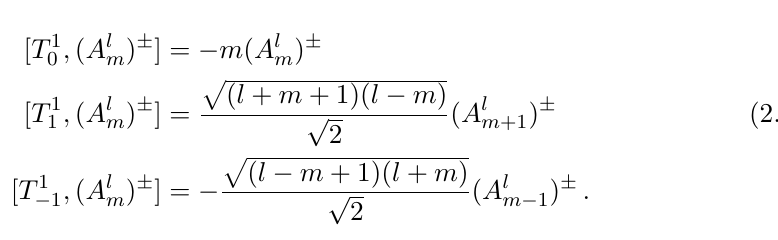
Figure 1 . Generation of chiral generators starting from A 2 to obtain A ‘ and then acting with T A ∓ = A 1 ∓ 1 ∓ ‘